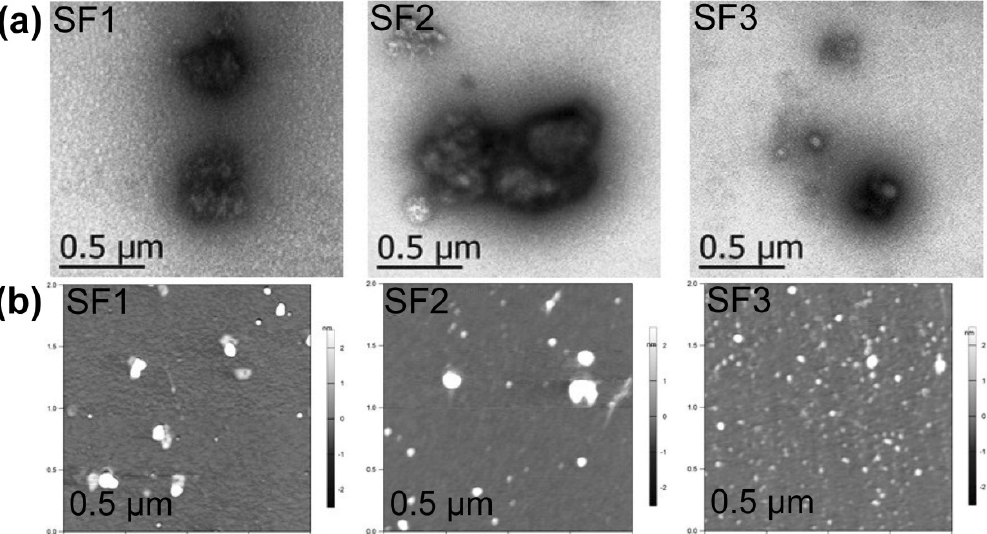
Figure 3. ( a ) TEM micrographs of SF1–SF3 dried aggregates at 21,000× magnification; ( b ) AFM micrographs of SF1–SF3 dried aggregates (see structures in Figure 1).